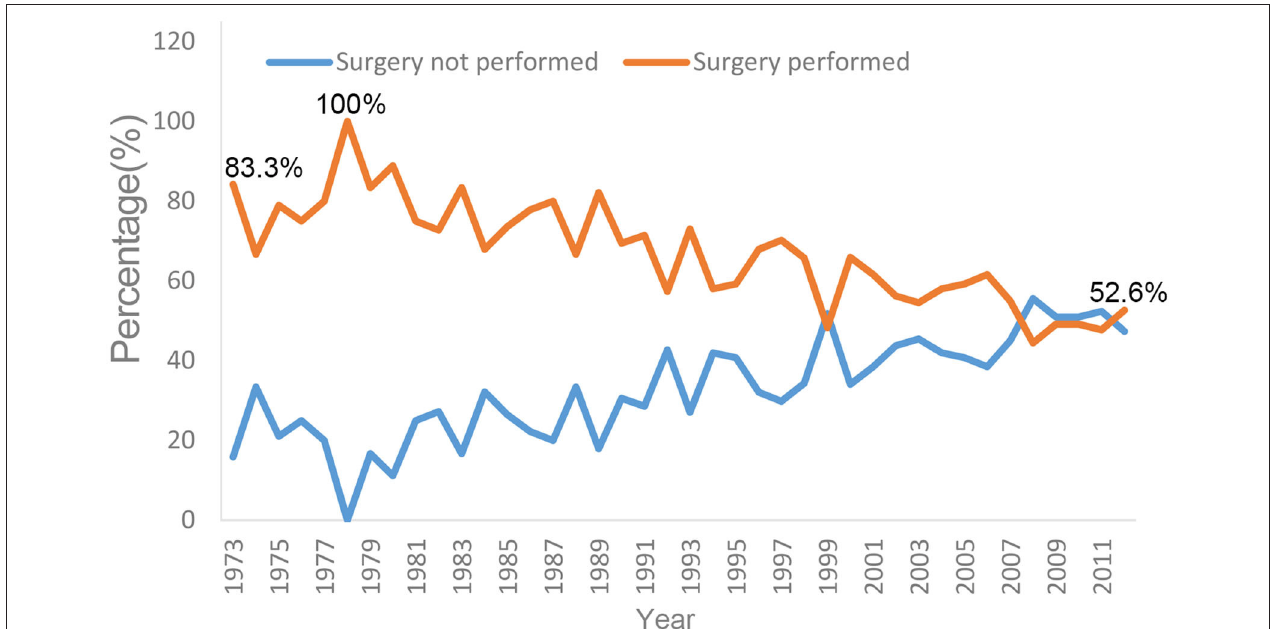
FIGURE 3 | Trends in surgery and non-surgery therapy in SEER 18 registries,